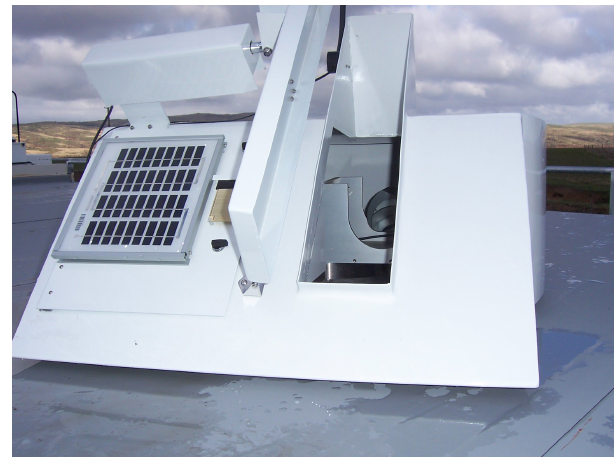
Figure 14. Our completed tracker inside the matching automated weatherproof